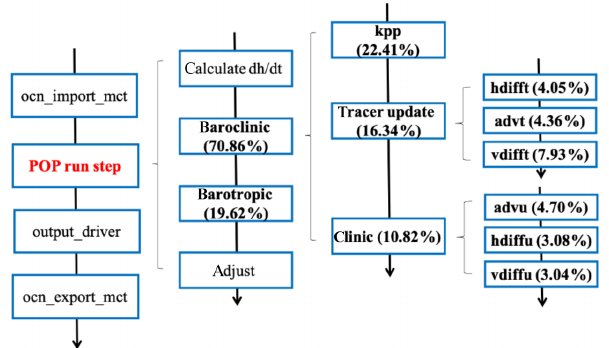
Figure 5. The major consumers of run time in the POP2 model. The profiling is performed with a 10km POP2 run using 18300 MPI